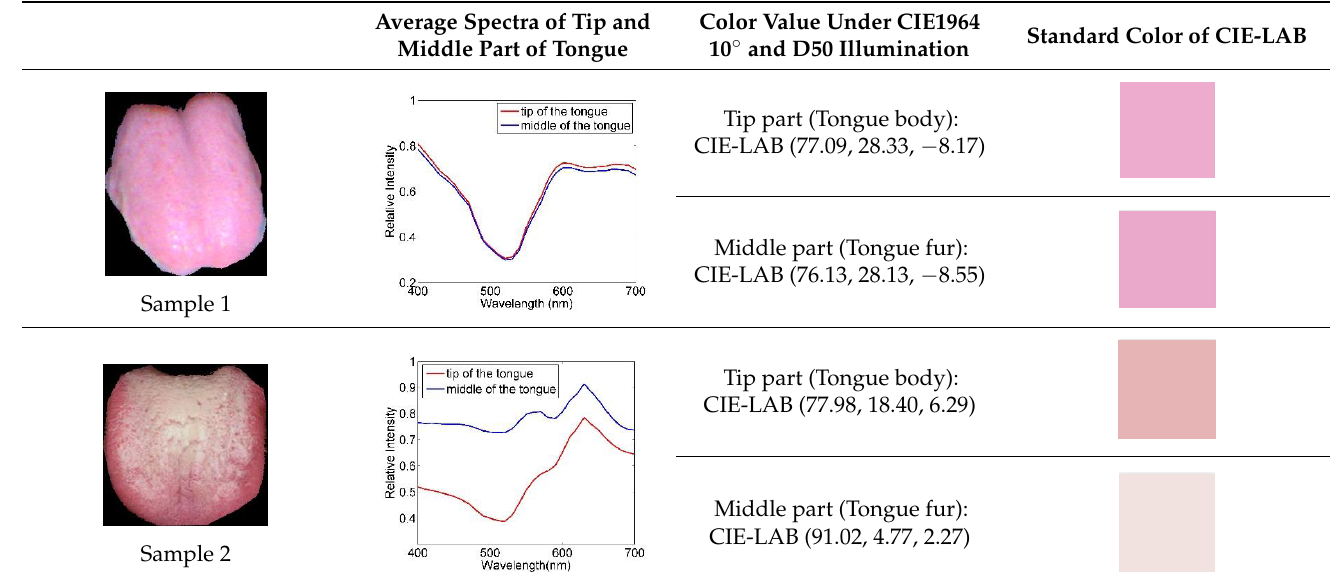
Table 2. Tongue body color and fur color of two samples.